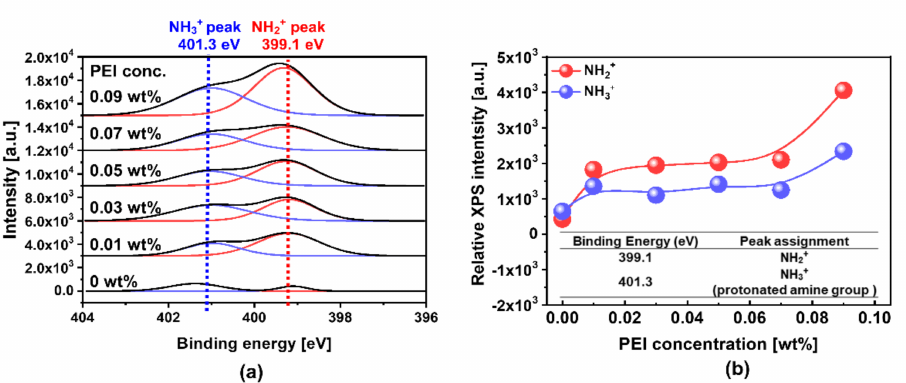
Figure 7. Dependency of chemical composition of Ge 1 Sb 4 Te 5 film surface on corrosion inhibitor (i.e., PEI) concentration corrosion inhibitor (i.e., PEI) concentration after Ge 1 Sb 4 Te 5 film surface CMP. ( a ) NH 3+ and NH 2+ spectra. ( b ) Dependency of relative NH 3+ and NH 2+ peak intensity on corrosion inhibitor concentration of Ge 1 Sb 4 Te 5 film surface after CMP.